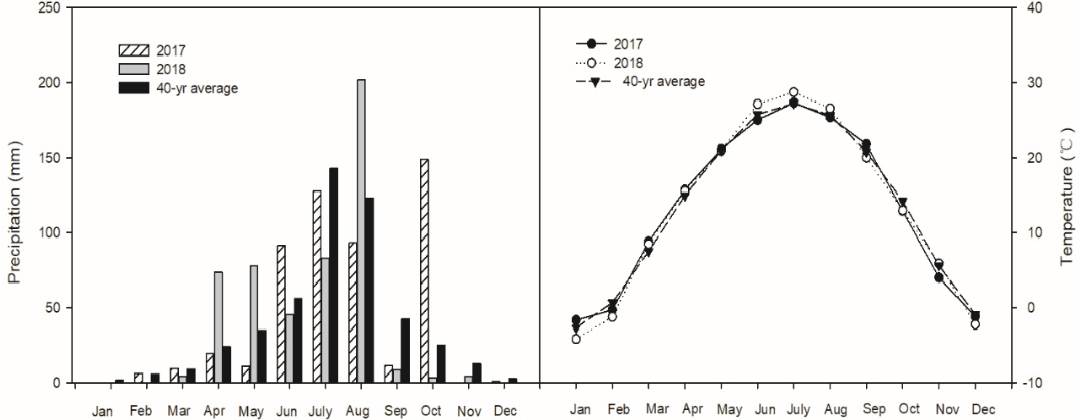
Figure 1. Monthly precipitation totals and temperature averages for 2017–2018 and 40-yr average (1980–2019).